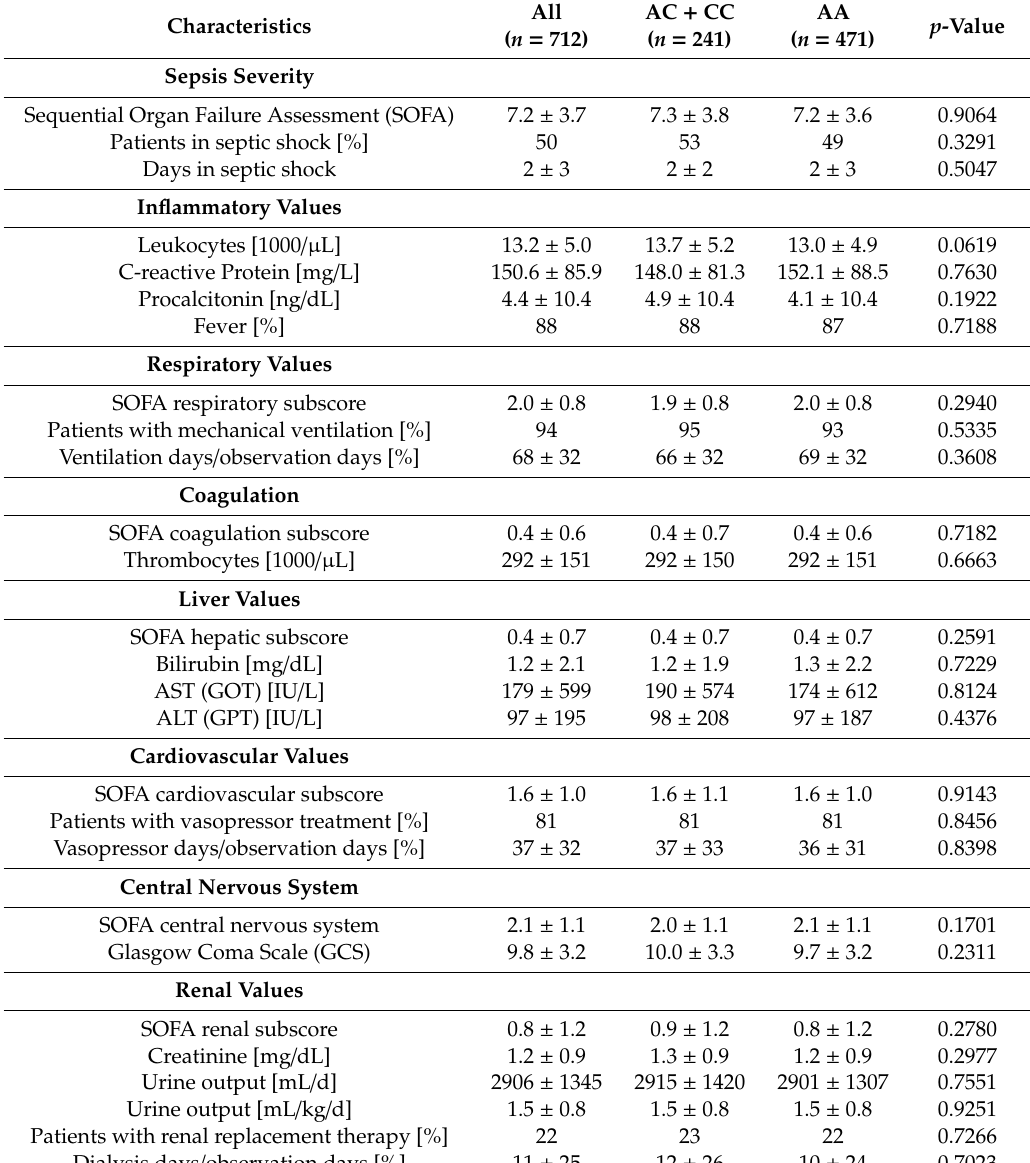
Table 3. Disease severity regarding the TIM-3 rs1036199